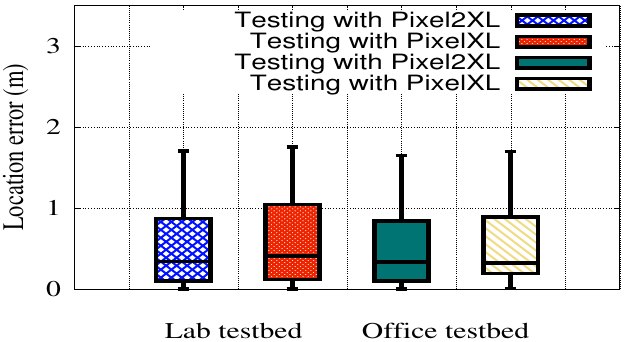
Figure 17. Effect of varying the testing device on RRLoc performance in the two